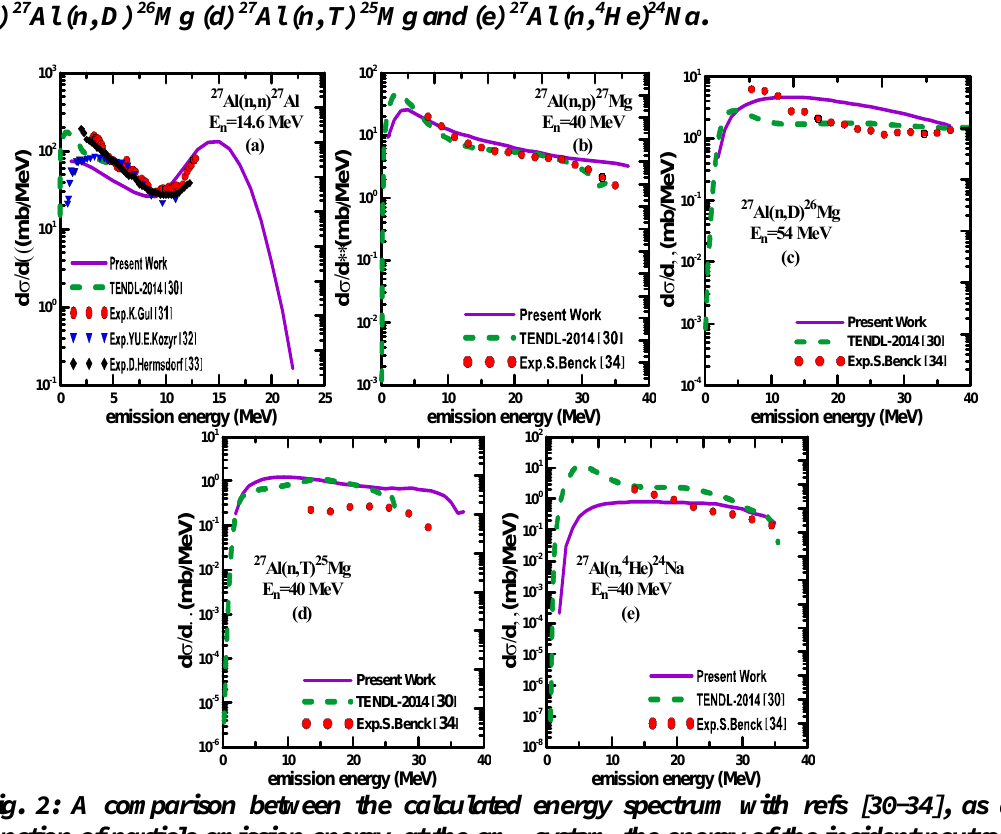
Fig. 1: The energy spectrum of different mechanisms as a function of the particle emission energy in cm-system for emission Nucleons (n and p) and light nuclei (D, T and 4 He), for different reactions and at incident energy 14.1MeV, (a) 27 Al (n, n) 27 Al (b) 27 Al (n, p) 27 Mg (c) 27 Al (n, D) 26 Mg (d) 27 Al (n, T) 25 Mg and (e) 27 Al (n, 4 He) 24 Na.